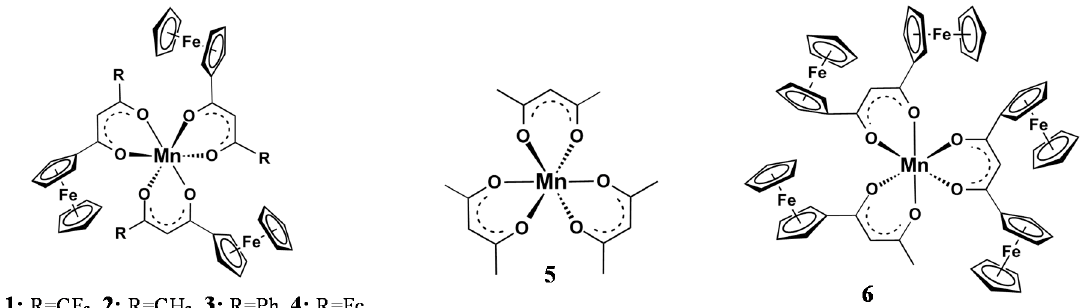
Figure 1. Structures of 1 – 6 .